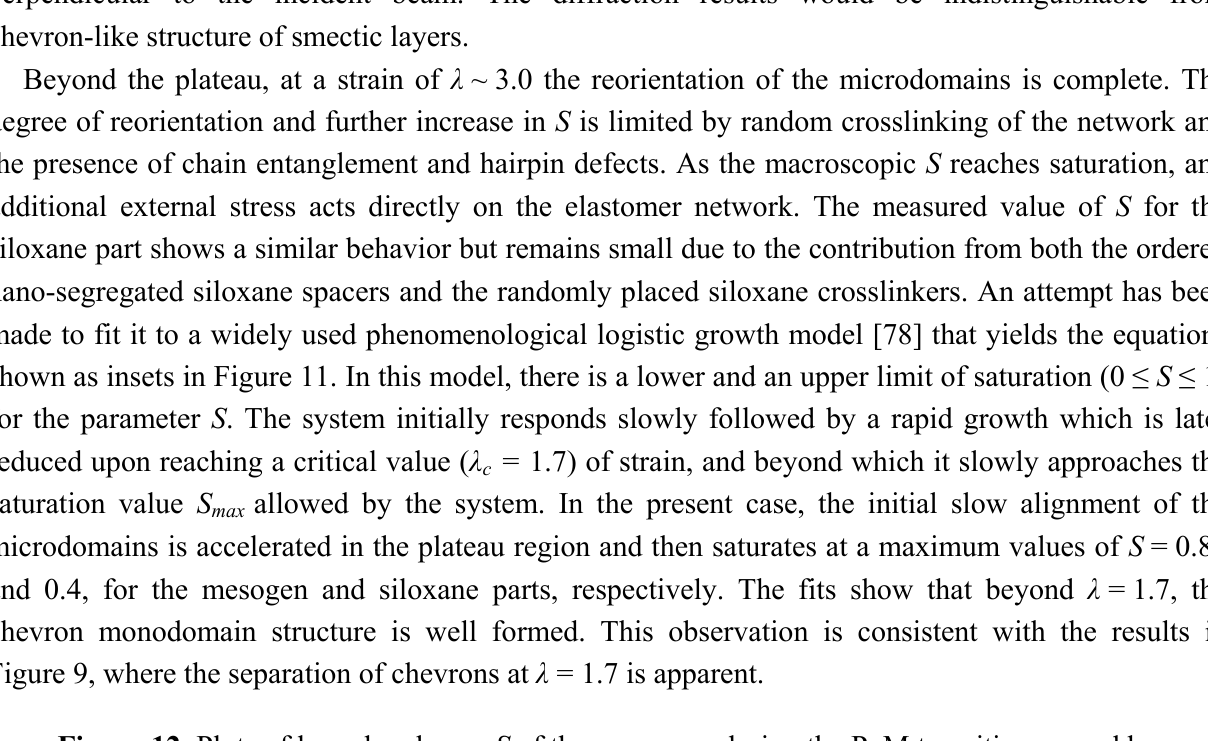
Figure 12. Plots of layer bend α vs. S of the mesogens during the P–M transition caused by uniaxial stretching show linear correlation between the two quantities. Clearly, the reorientation of the chevron domains towards the stretch direction is related to the increasing orientational order of the mesogenic